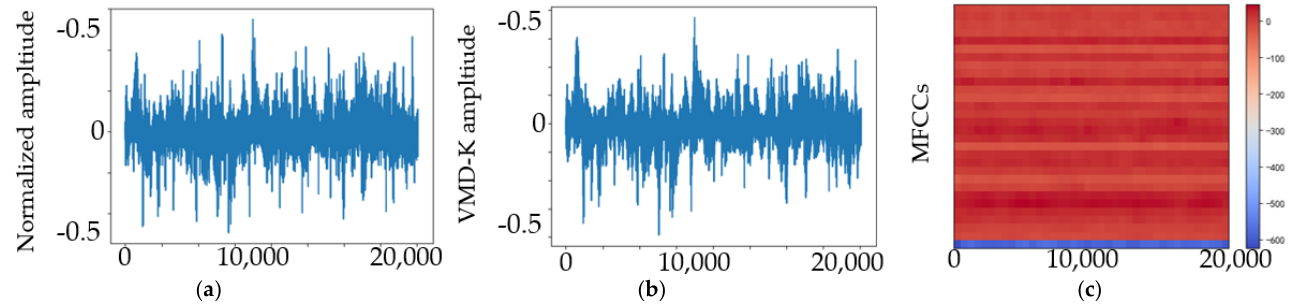
Figure 8. AE signals of the RE damage state at 20 rpm and 100 kN radial load: ( a ) original signal; ( b ) signal after denoising; ( c ) MFCCs.